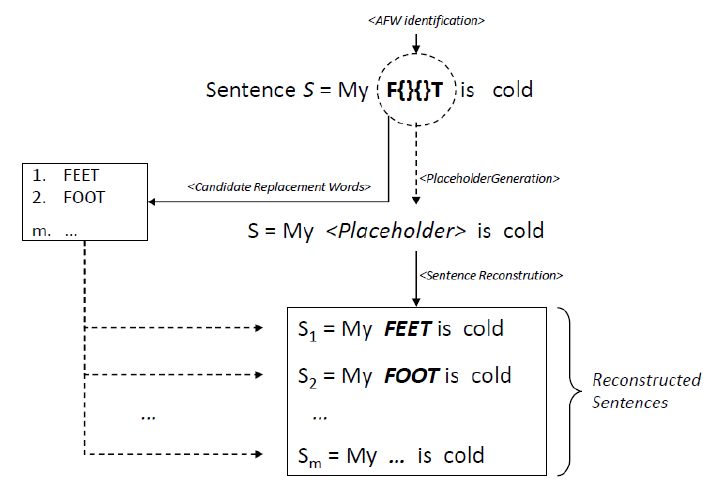
Figure 6. An example of the sentence reconstruction